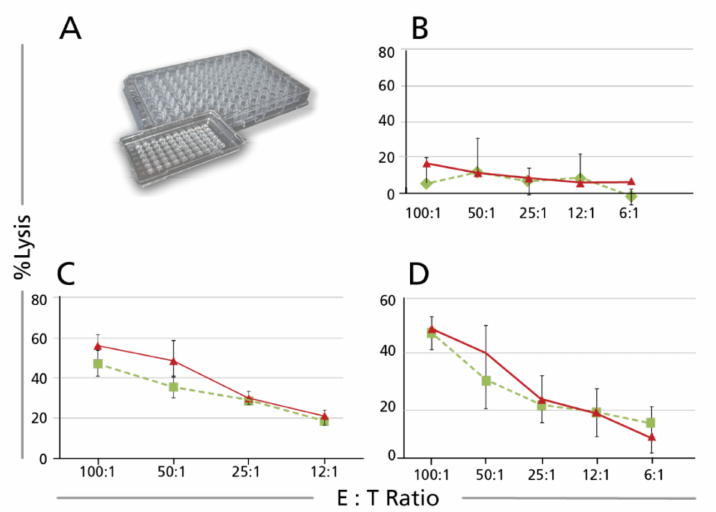
Figure 4. The Mini Calcein TVA assay compared with that performed in 96 well format. ( A ) shows a photograph of a Terasaki plate next to a regular 96 well plate. Calcein TVA Assays were done in parallel in both plate formats, using the same effector-target cell mixtures, of which 200 µ L were plated into the 96 well U bottom plates (green lines), and 20 µ L per well into the Terasaki plate (red lines). The results for three donors tested in parallel are shown in panels ( B – D ),